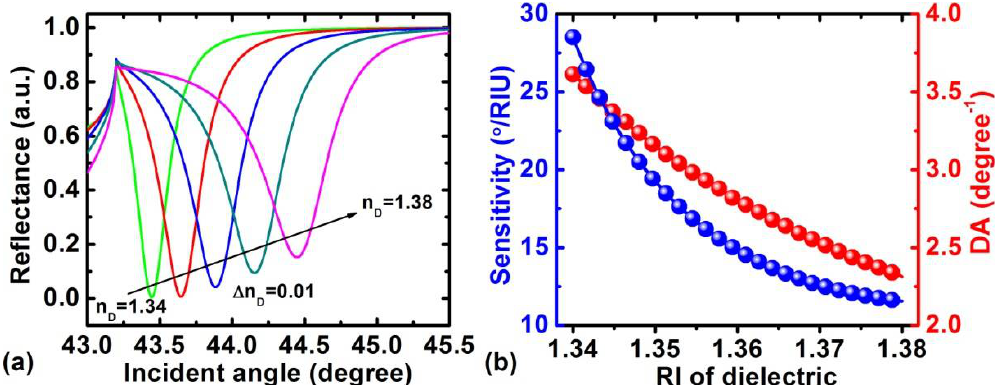
Figure 4. ( a ) Variation of the reflectance with the incident angle for different refractive indices(RIs) of the dielectric layer for n s = 1.33, d D = 2000 nm and d G = 18 nm; ( b ) variation in the sensitivity and detection accuracy (DA) with RI of the dielectric layer.